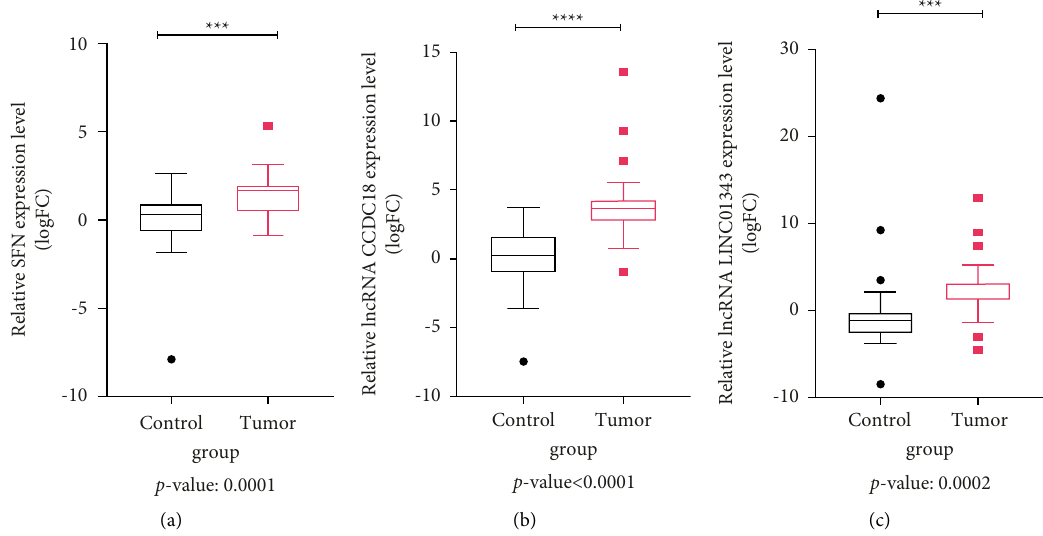
Figure 4: The expression level of SFN , CCDC18-AS1, and LINC01343 in tumor tissues ( n � 24) compared to the normal tissues ( n � 24) by qRT-PCR. Figures demonstrated the high expression of SFN , CCDC18-AS1, and LINC01343 in tumor samples compared to the normal samples ( ● outlying data of control groups, ■ outlying data of tumor groups, ∗∗∗ p value < 0.001, ∗∗∗∗ p value <